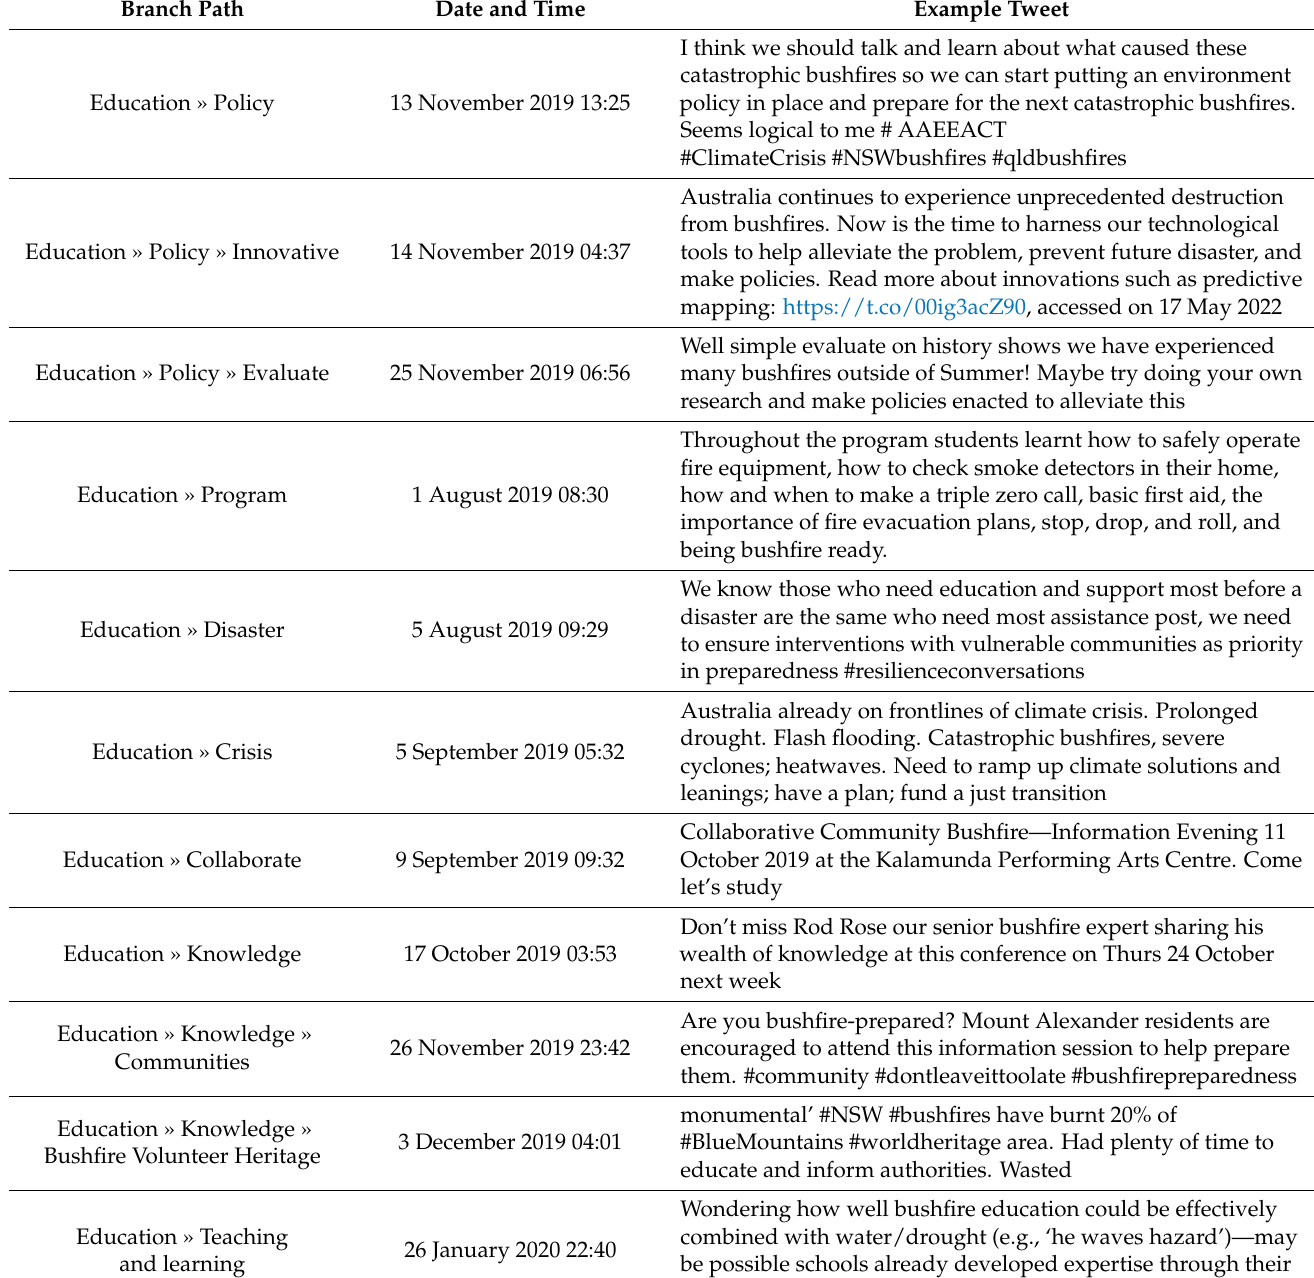
Table 1. Exemplar tweets for each branch of the word